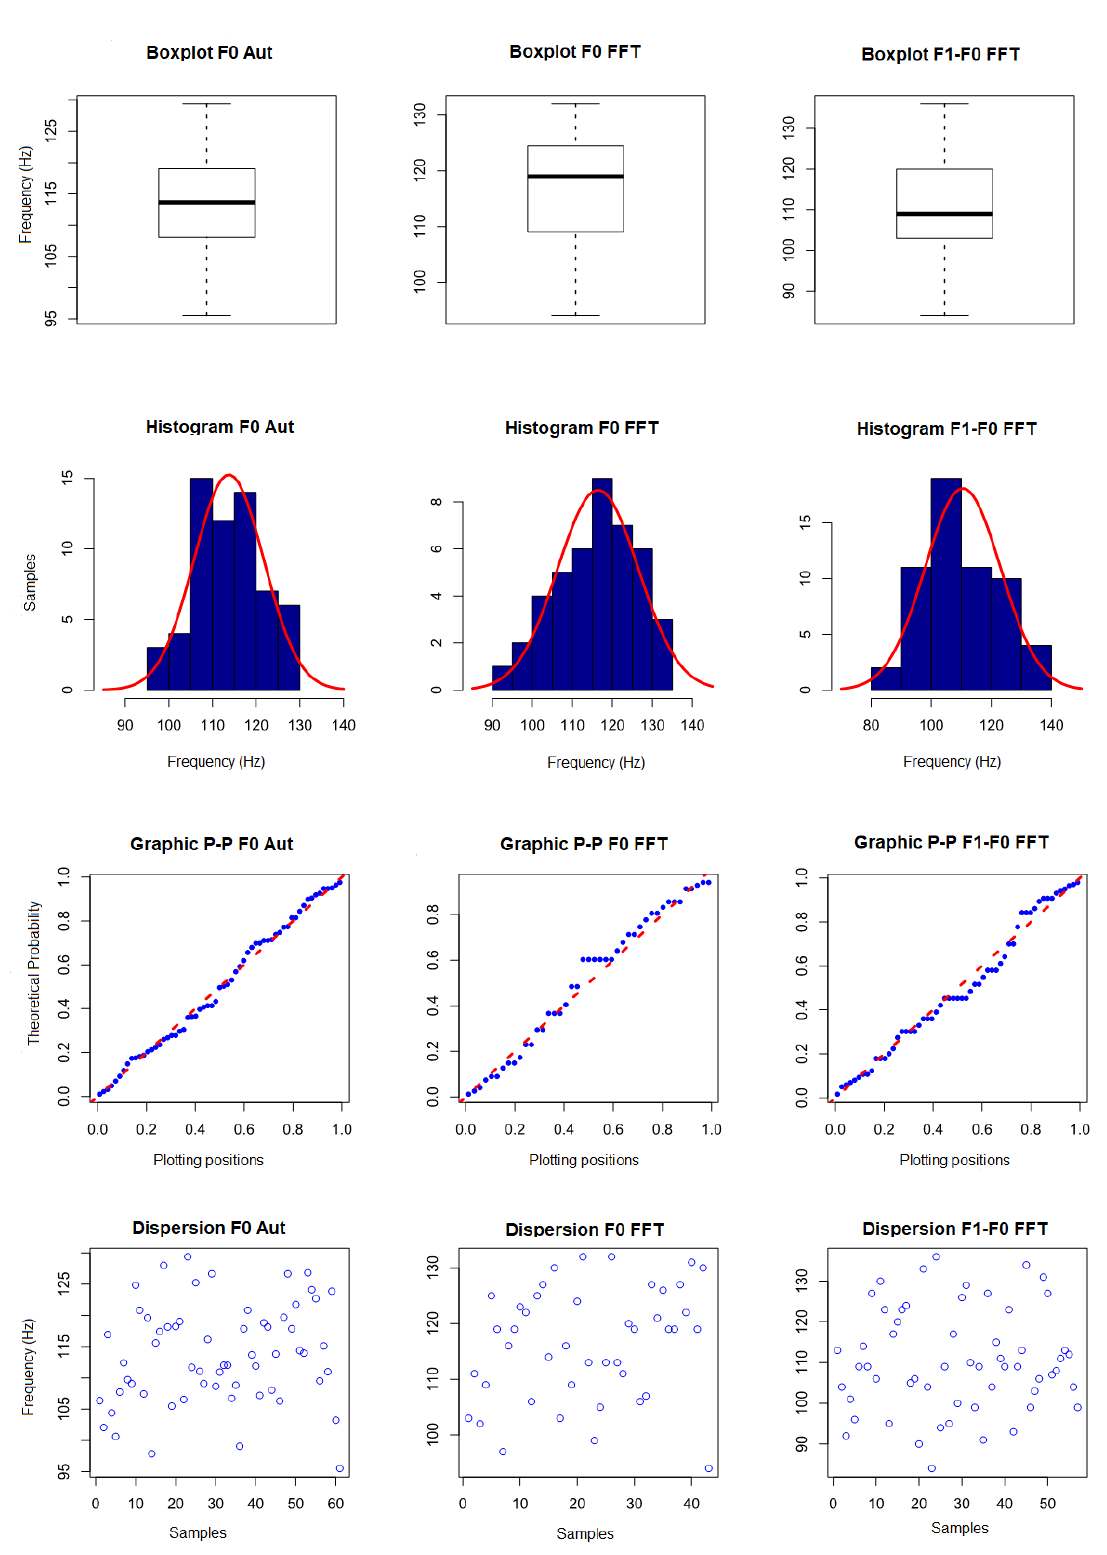
Figure 22. Graphics of the visual evaluation of the data obtained with the events of passage of A. fraterculus of the standard group with removal of